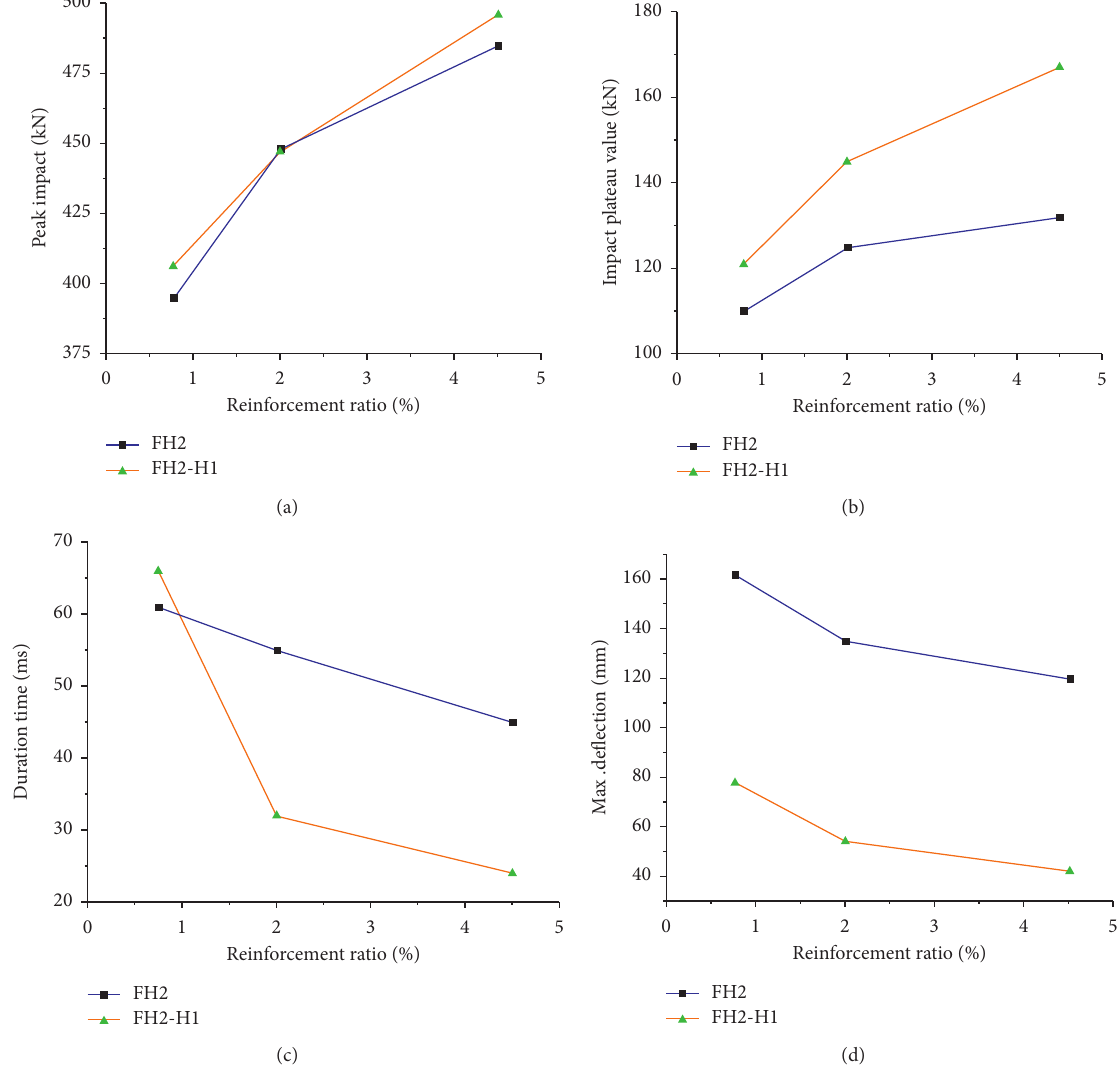
Figure 16: The effect of reinforcement ratio on the forces. (a) Reinforcement ratio-impact peak relationship. (b) Reinforcement ratio-impact force platform value relationship. (c) Reinforcement ratio-impact time duration relationship. (d) Reinforcement ratio-maximum deflection